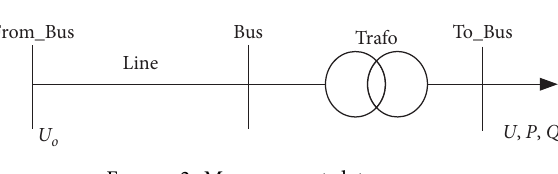
Figure 1: Calculation process.